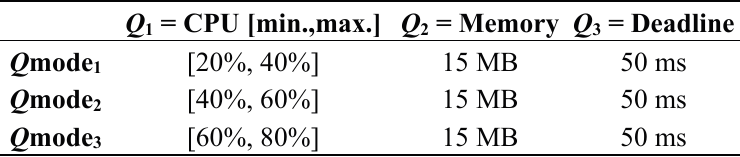
Table 2. Possible Q modes for system